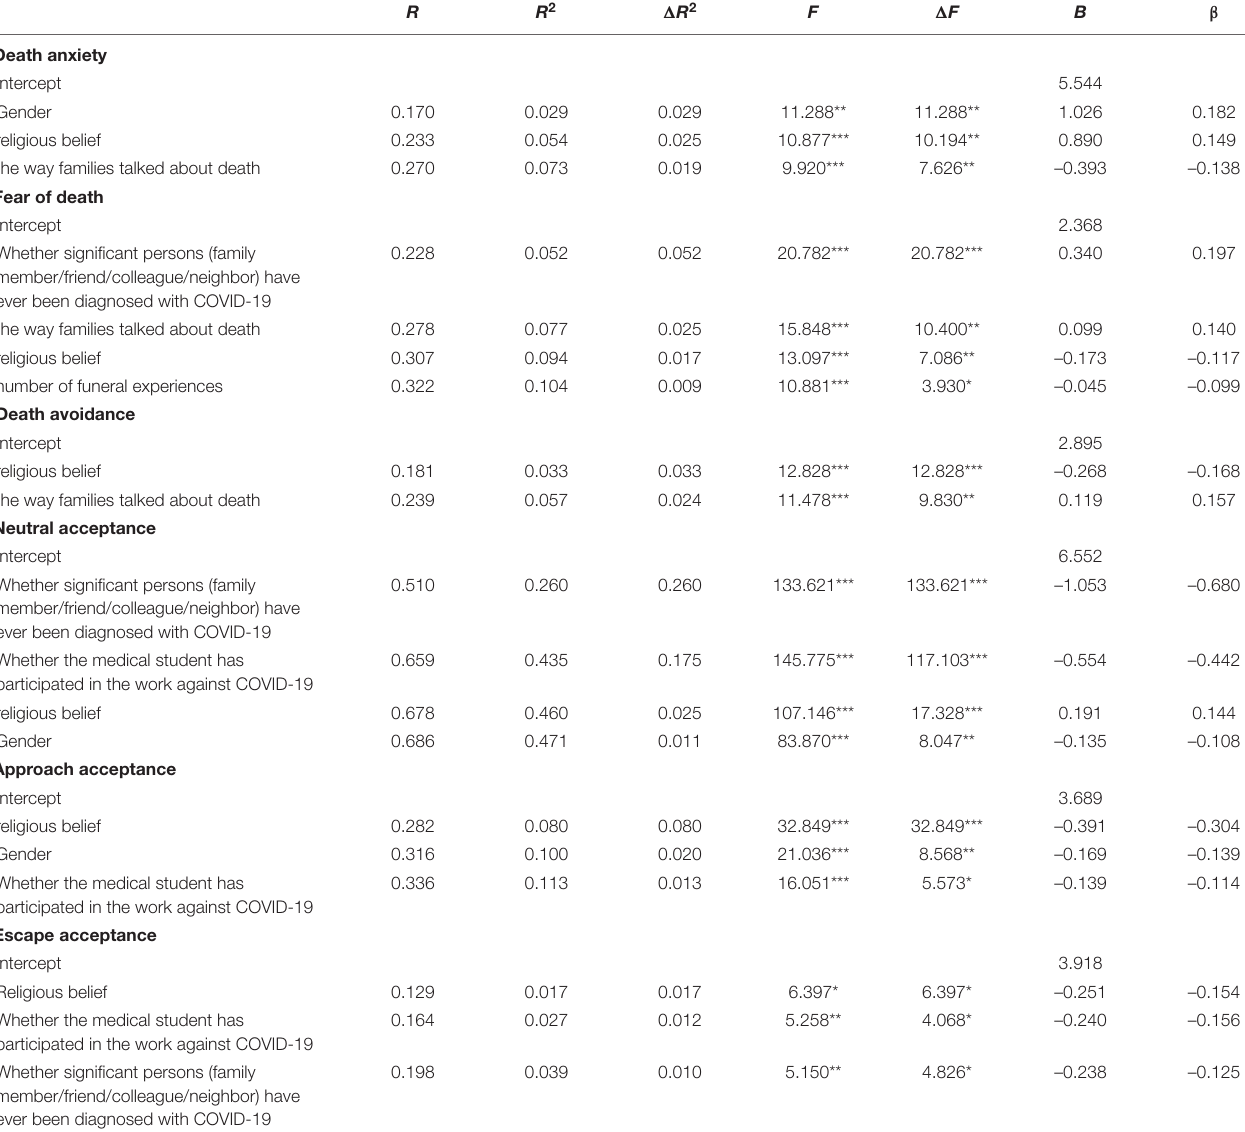
TABLE 8 | Summary of stepwise regression analysis of various influencing factors of